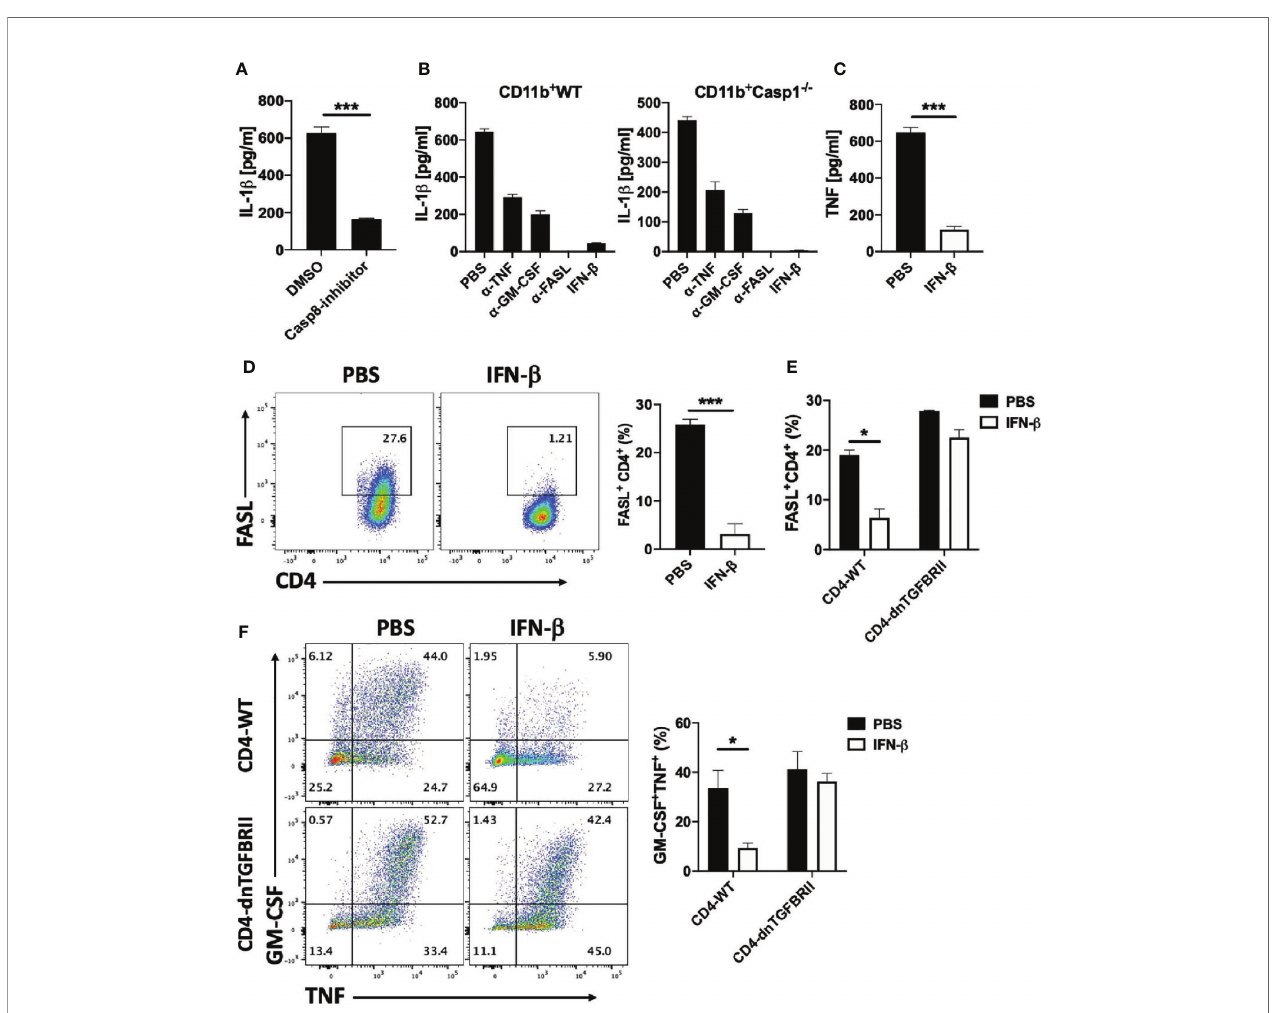
FIGURE 8 | rIFN- b suppresses IL-1 b expression in myeloid cells via inhibition of FASL expression by Th cells. Splenic naïve CD4 + T cells and CD11b + cells were activated with anti-CD3/28 Abs with addition of caspase-8 inhibitor or DMSO into culturing media. (A) IL-1 b concentrations in cell culture supernatants measured by ELISA after 72 h of culturing. (B) Splenic WT naïve CD4 + T cells were co-cultured with WT or Casp1 -/- CD11b + cells and activated with anti-CD3/28 Abs, with or without addition of anti-TNF, anti-GM-CSF, anti-FASL Abs or rIFN- b into culturing media. IL-1 b concentrations in cell culture supernatants were measured by ELISA after 72 h of culturing. (C) Splenic naïve CD4 + T cells and CD11b + cells were co-cultured and activated with anti-CD3/28 Abs with or without addition of rIFN- b into culturing media. TNF concentrations in cell culture supernatants were measured by ELISA after 72 h of culturing. (D) Representative fl ow cytometry dot plots showing FASL expression by CD4 + T cells in (C) Proportions (%) of FASL + CD4 + T cells in (C, E) Splenic naïve CD4 + T cells from WT or CD4-dnTGFBRII mice were co- cultured with WT CD11b + cells activated with anti-CD3/28 Abs, with or without addition of rIFN- b into culturing media. Proportions (%) of FASL + CD4 + T cells were analyzed by fl ow cytometry. (F) Representative fl ow cytometry dot plots showing GM-CSF and TNF expression by WT CD4 + and CD4-dnTGFBRII T cells in (E) Bar graph showing proportions (%) of GM-CSF + TNF + CD4 + T cells by WT CD4 + and CD4-dnTGFBRII T cells in (E) These experiments were conducted two (A, B, E, F) and three times (C, D) with similar outcomes. Data shown are mean ± SEM. P-values were calculated using unpaired Student ’ s t- test; *p < 0.05, ***p <